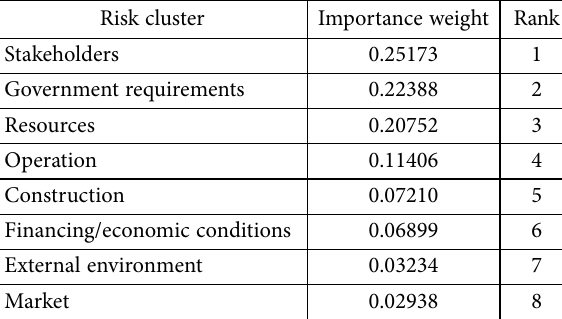
Figure 3. The risk assessment